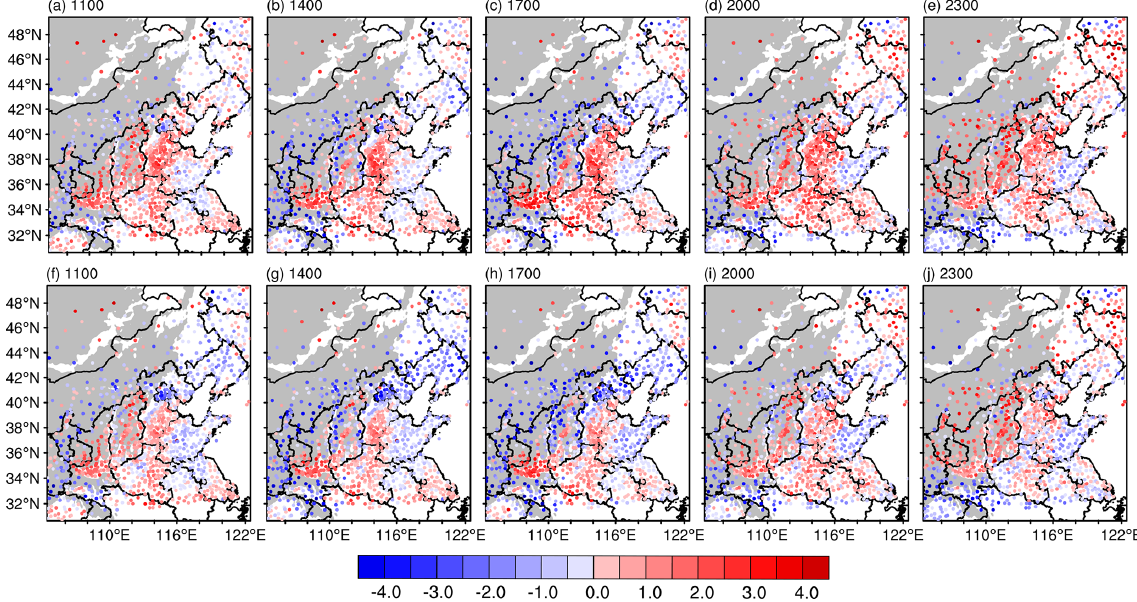
Figure 11. The bias of 2m temperature ( ◦ C) at (a) 11:00LT, (b) 14:00LT, (c) 17:00LT, (d) 20:00LT and (e) 23:00LT in NoAero averaged from 6 to 10 December 2015. Panels (f–j) are the same as (a–e) , but for Aero. The gray areas denote the areas of terrain height above 1000m.